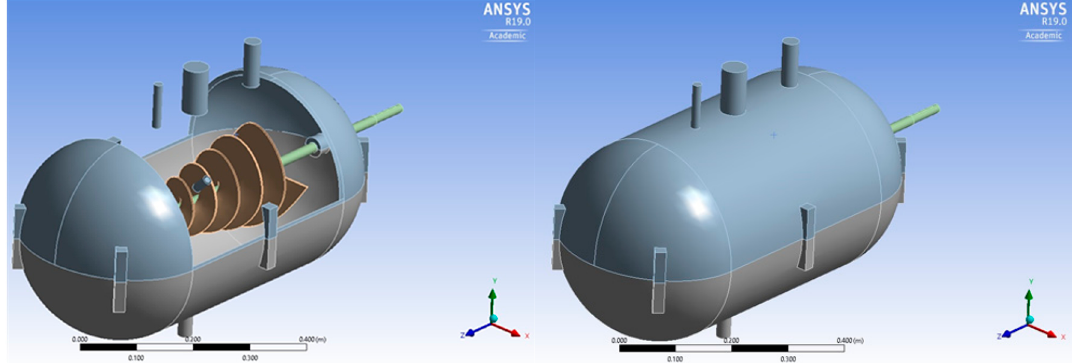
Figure 1. Section of designed reactor for MSW steam-based